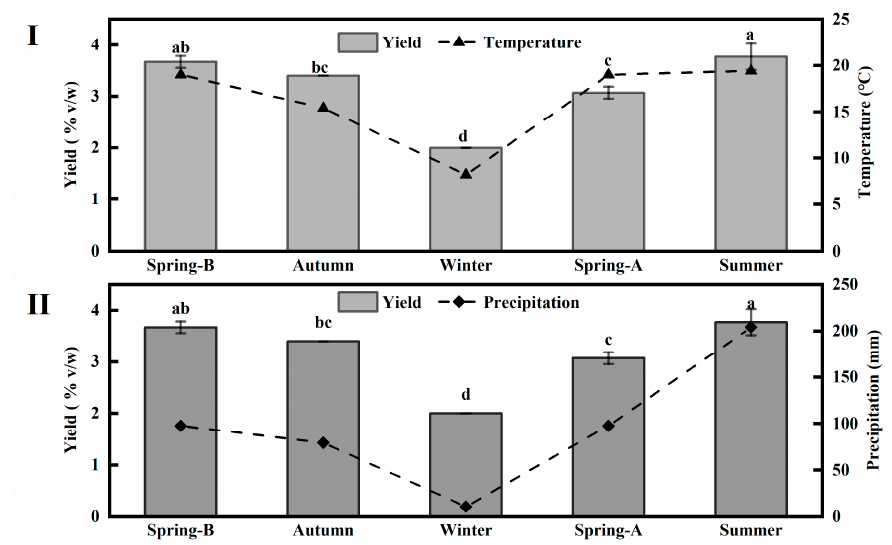
Figure 1. The mean yields of essential oil (%), temperature ( ◦ C) ( I ), and precipitation (mm) ( II ) during the sampling period. Yield defined as the total mass of extracted oils expressed as % of plant material fresh mass; Results are provided as mean ± SD; Values with different letters are significantly different ( p < 0.05), according to Tukey’s multiple range test; Kunming climate data derived from China Meteorological Administration.